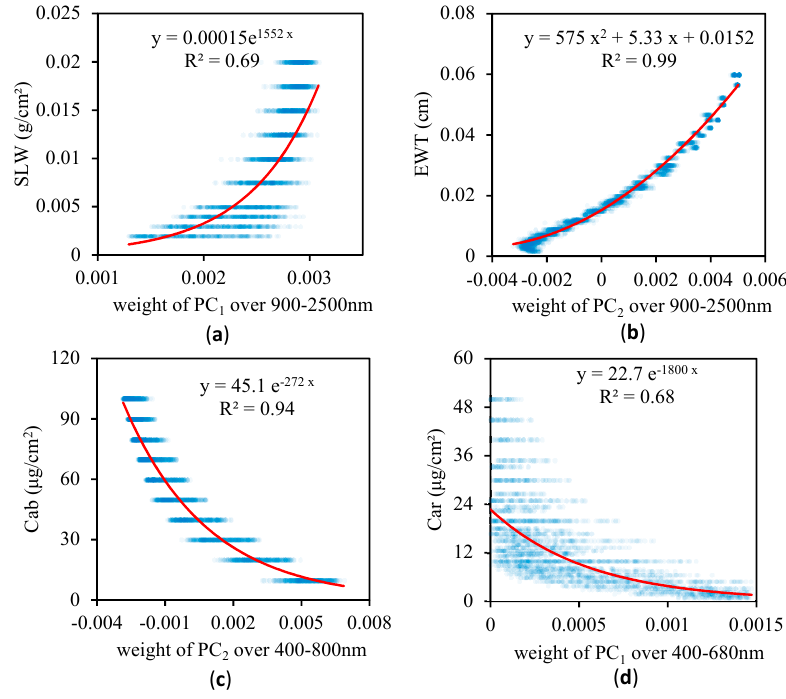
Figure 6. The regression models for the specific leaf weight (SLW) ( a ), equivalent water thickness (EWT) ( b ), chlorophyll content ( c ) and carotenoid content ( d ) derived using the weighting coefficients of the most sensitive principal component (PC), as given in Table 4. R 2 is the determination coefficient.